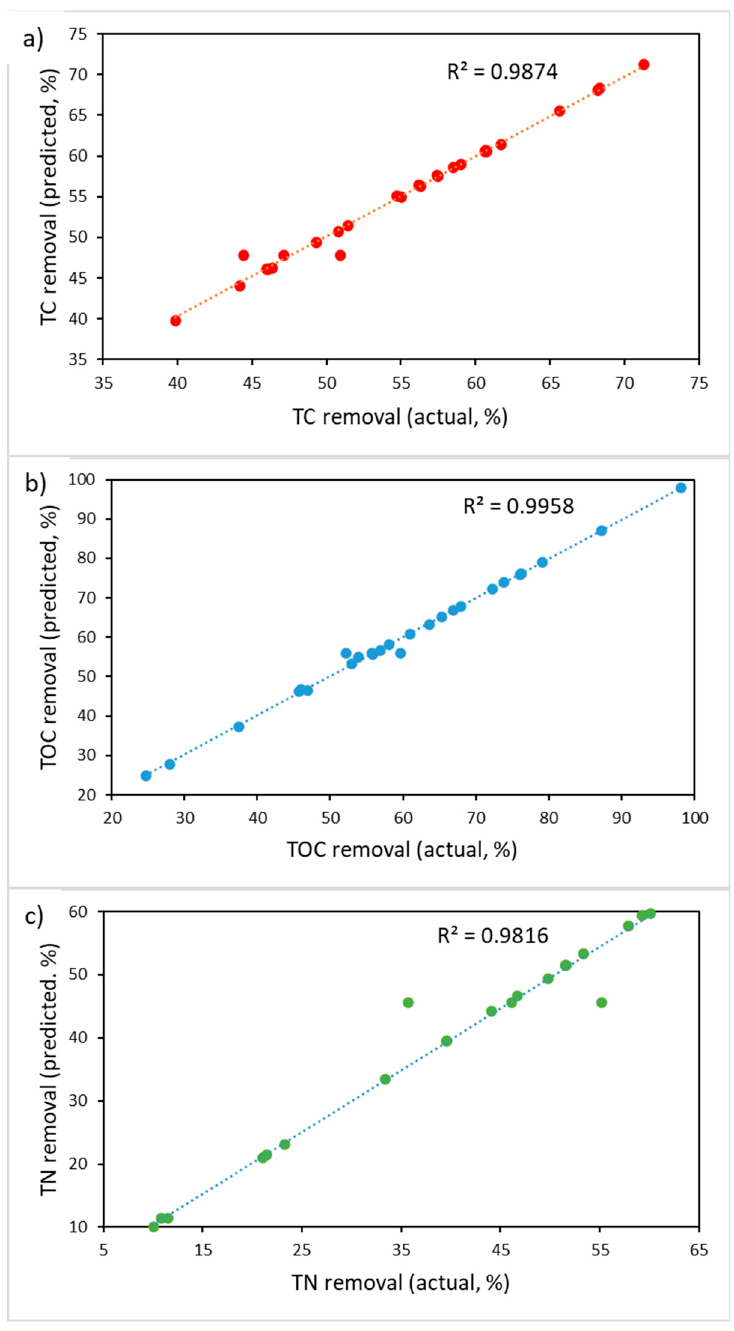
Figure 6. ANN predicted vs. actual values for ( a ) TC removal, ( b ) TOC removal, and ( c ) TN removal.